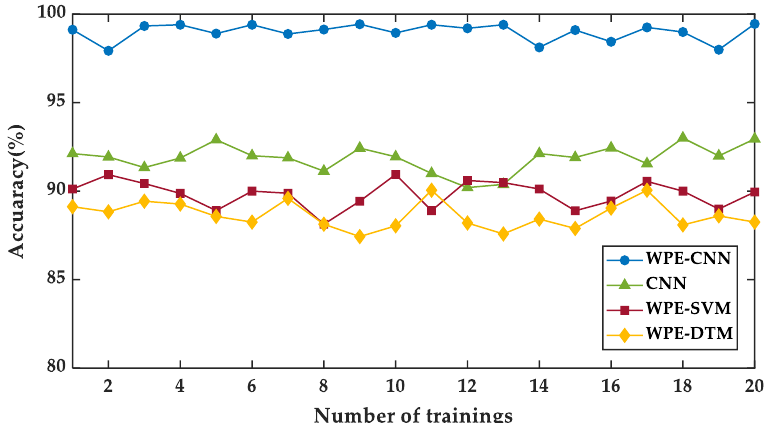
Figure 11. Comparison of classification accuracy with three models.